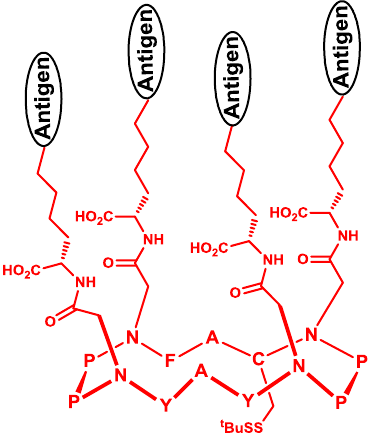
Figure 6. Multivalent template of a cyclopeptide.